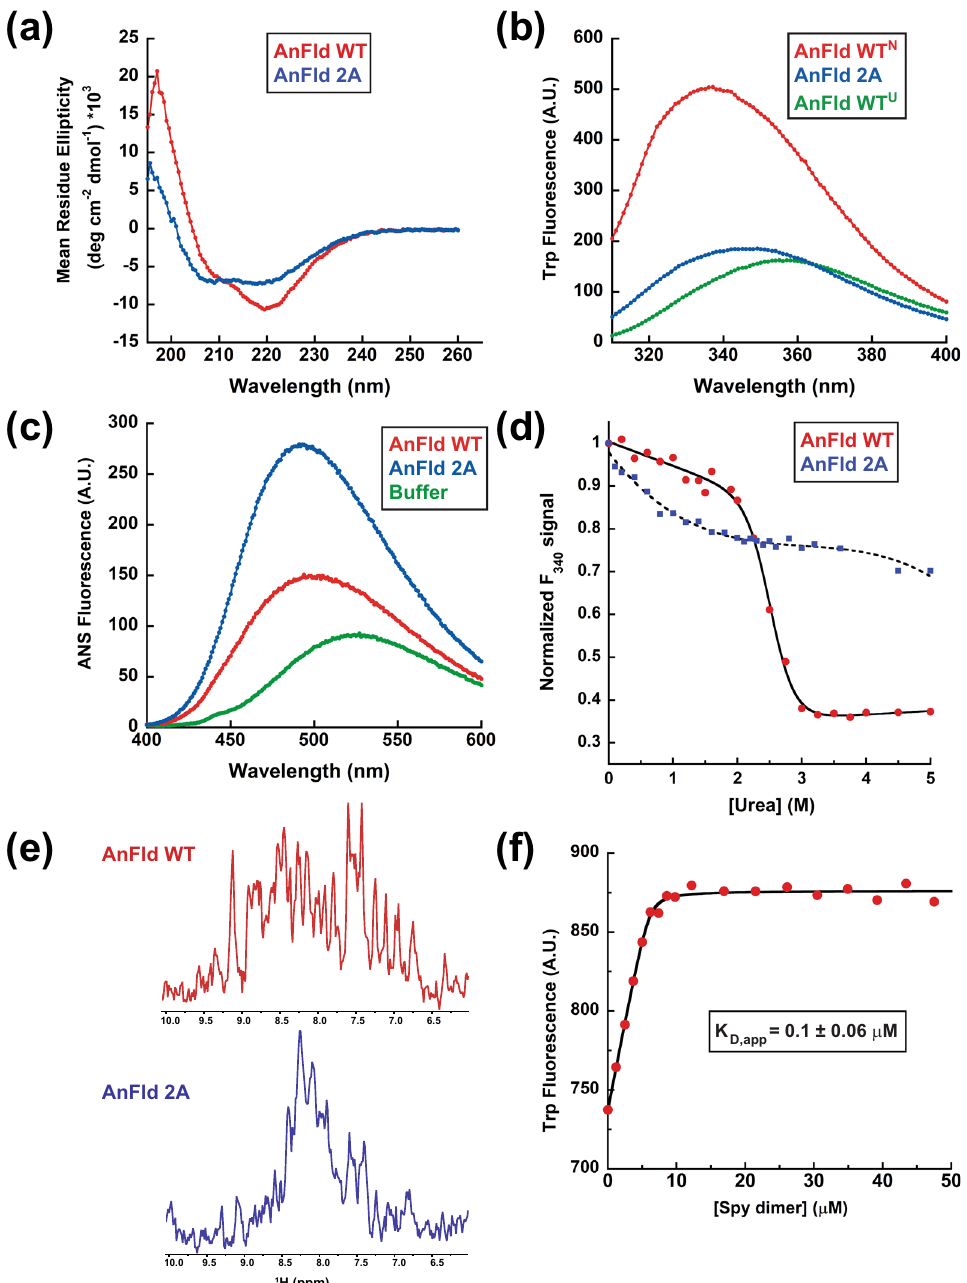
Fig. 3 Characterization of the AnFld2A mutant and its interaction with Spy. a Far-UV CD spectra of AnFld WT (red) and AnFld2A mutant (green) in 0.1 M potassium phosphate buffer (pH 7.5) at 25 °C. b Intrinsic tryptophan fl uorescence emission spectra of the native states of AnFld WT (green), AnFld 2A mutant (blue), and denatured AnFld WT in 5 M urea (red) in HN buffer at 25 °C. c Fluorescence emission spectra of ANS alone (red) in HN buffer and in the presence of AnFld WT (green) or AnFld 2A mutant (blue) in HN buffer at 25 °C. The fl uorescence intensity of ANS increases 2.8-fold upon binding the mutant compared to the WT. d Urea-induced denaturation of AnFld WT (red) and AnFld 2A mutant (blue) monitored by tryptophan fl uorescence emission at 340 nm in HN buffer at 25 °C. The data were normalized to the fl uorescence signal ( F 340 ) of each protein in the absence of urea. The denaturation curve of the WT protein was fi t to a two-state unfolding model (solid black line) and that of AnFld 2A was fi tted to a third-degree polynomial (broken black line). e 1 H dimension of the 2D [ 1 H- 15 N] HSQC – TROSY spectra of 0.2 mM AnFld WT (red) and 2 A (blue). f Titration of Spy dimer to 10 µ M AnFld 2A as monitored by the intrinsic tryptophan fl uorescence. The black line shows the fi t of the fl uorescence intensity as a function of Spy dimer concentration to a tight binding model. A.U. arbitrary units. Value reported is the mean ± s.e.m. of the fi t. Source data are provided as a Source Data fi results from spectroscopy-based kinetic experiments and IM- of Spy induces compaction of a dynamic ensemble of unfolded MS reveal that such client compaction may also stabilize Im7 L18A L19A L37A 26 . The compaction of an unfolded client in complex with Spy is proposed to facilitate intramolecular kinetically trapped states that are unable to fold in a chaperone- contacts necessary to fold while bound 26,27 . Collectively, our bound form.